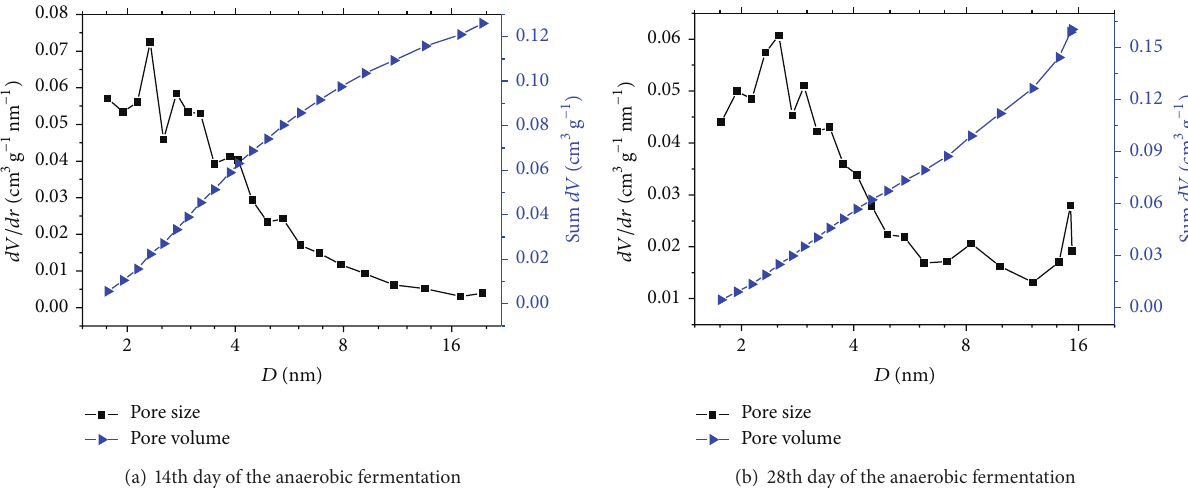
Figure 9: The distribution curve of pore volume and pore size of sample III.